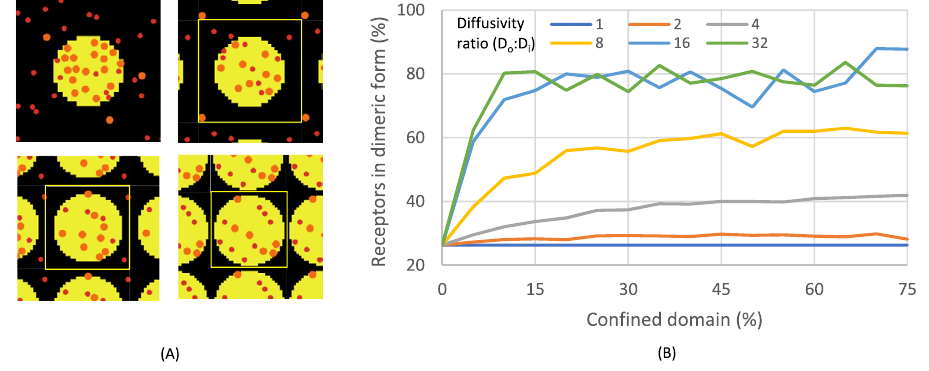
Figure 5. Increasing confined domain area induces more receptor dimerisation. Effect of increasing the confined domain area at different diffusivity ratios. ( A ) Snapshots of the occupied area of the confined domain (yellow circle) from upper left at 20%, 40%, 60% and 75%. Red and orange dots represent monomeric and dimeric receptors, respectively. Note that at higher area percentages, the number of receptors per box reduces, when the number of boxes per cell increases. The size of the confined domain was kept constant. ( B ) Results of simulation for receptor fractions in dimeric form. Simulations were run for ≥ 200,000 steps, with an average of the last 50,000 steps